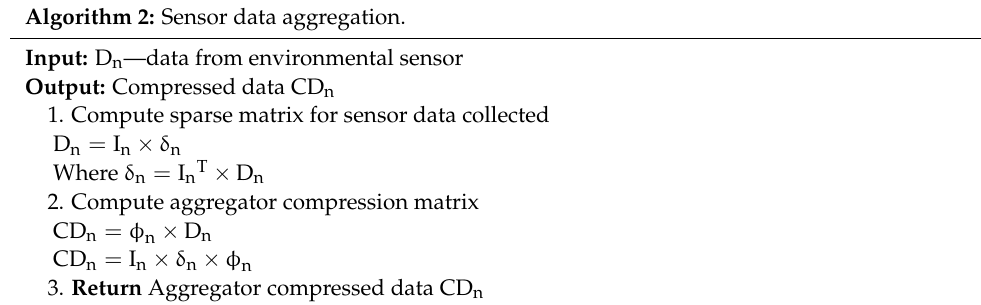
Algorithm 2: Sensor data aggregation.